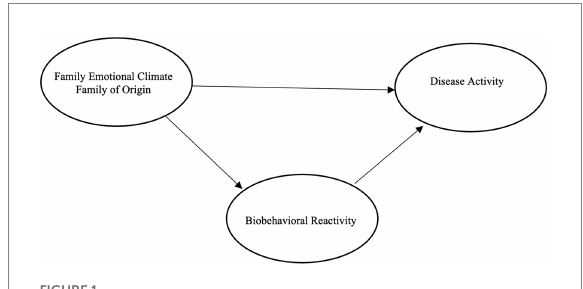
FIGURE 1 Hypothesized model with direct path.